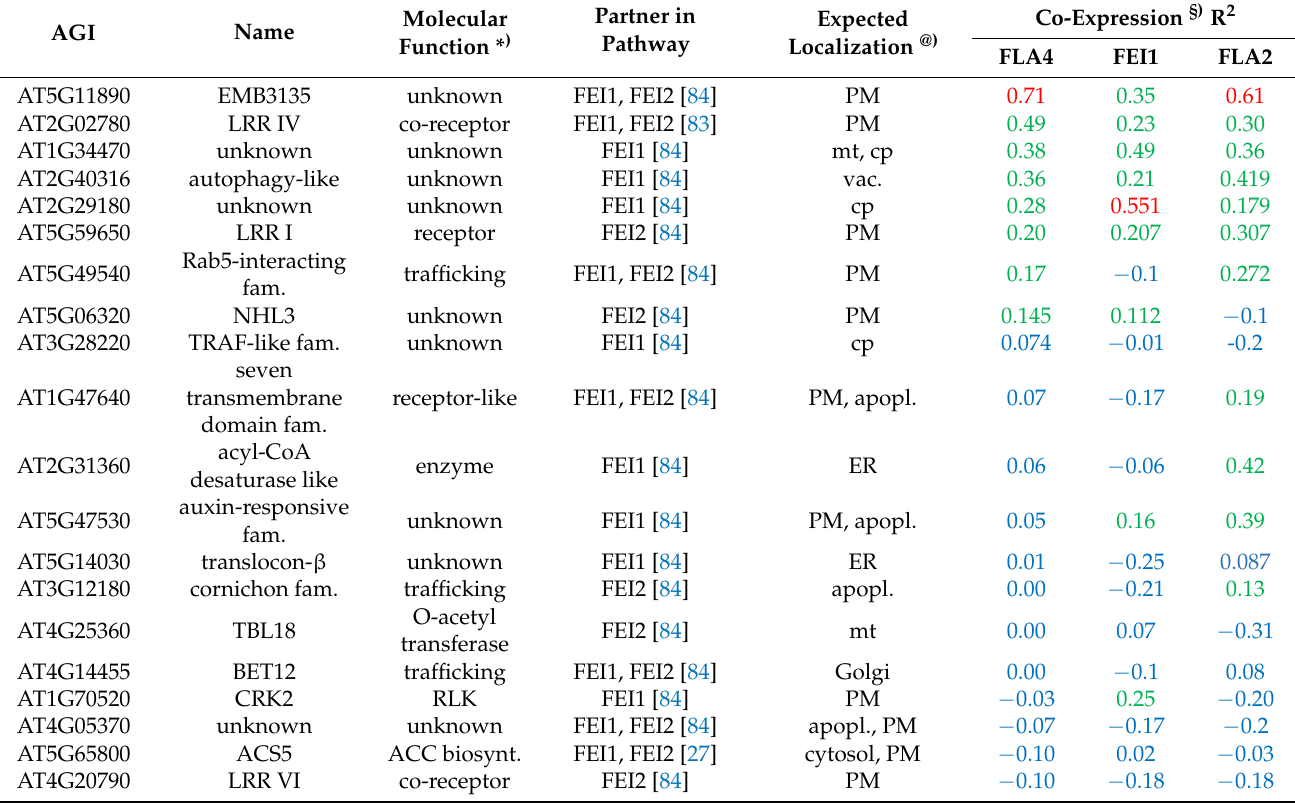
Table 2. Physical interactors of the FLA4-FEI